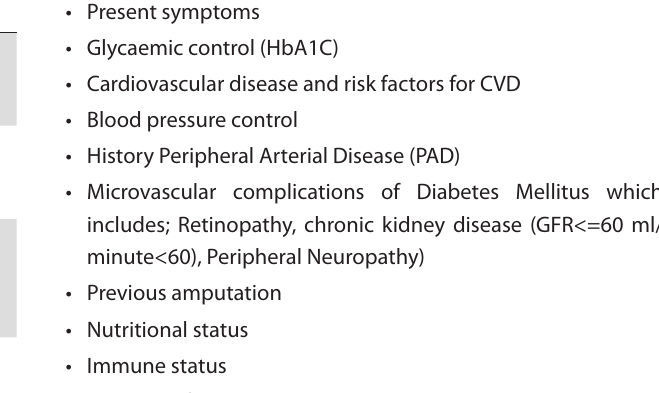
Table 2: Stratification of risk for utilising the 60 second screening tool Category Risk